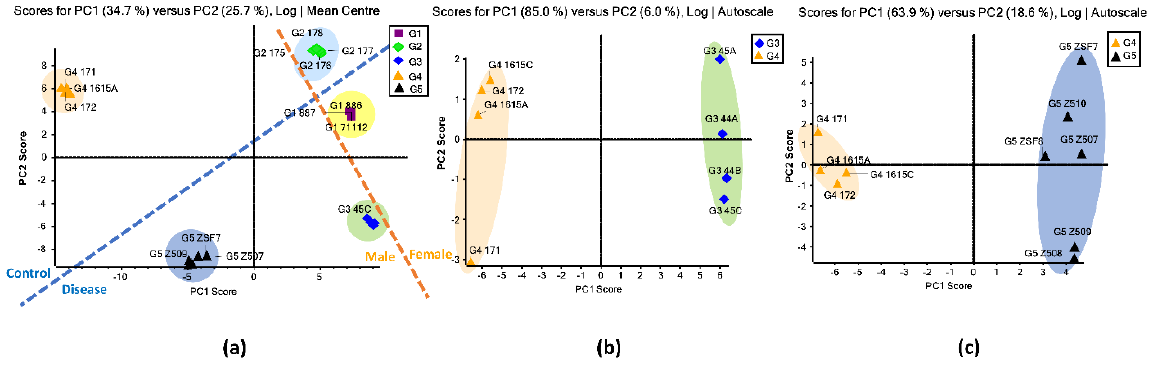
Figure 1. ( a ) Unsupervised PCA of the BBM O -glycans from the five sample groups. Symbols with the same color and shape were replicates from same sample group. ( b ) Unsupervised PCA of the BBM O -glycans from older males with proteinuria and hypertension (G3) and from the young male control (G4). ( c ) Unsupervised PCA of the BBM O -glycans from obese and diabetic male (G5) and from the young male control (G4). G3 were MWF male rats (32-42 weeks), G4 were MWF male rats (7 weeks), and G5 were ZSF1 male rats (16 weeks).